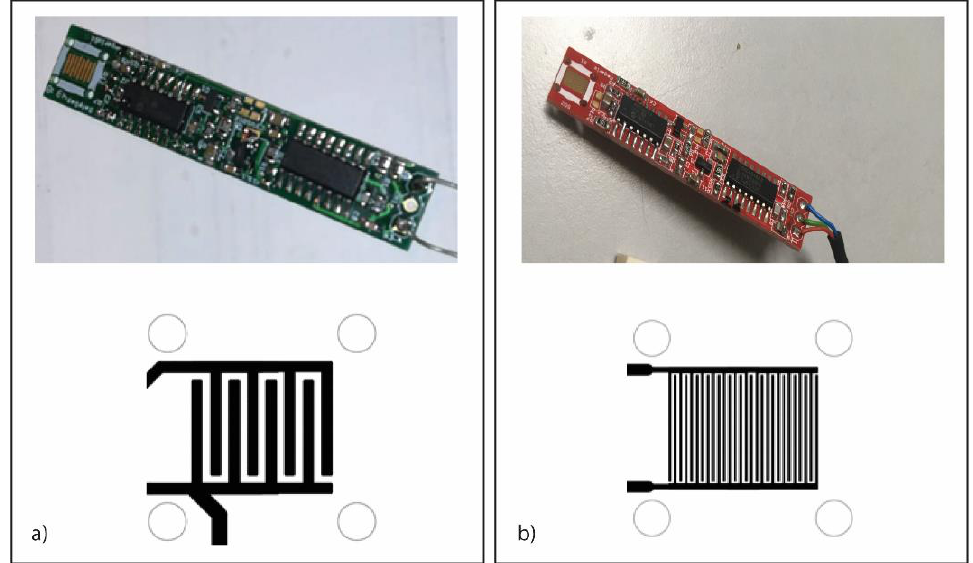
Figure 1. Gas sensor. Photo (on top) and scheme of sensing area (on bottom) of the gas sensor prototypes with a gold-plated IDE at 200 µm ( a ) and 75 µm ( b ).